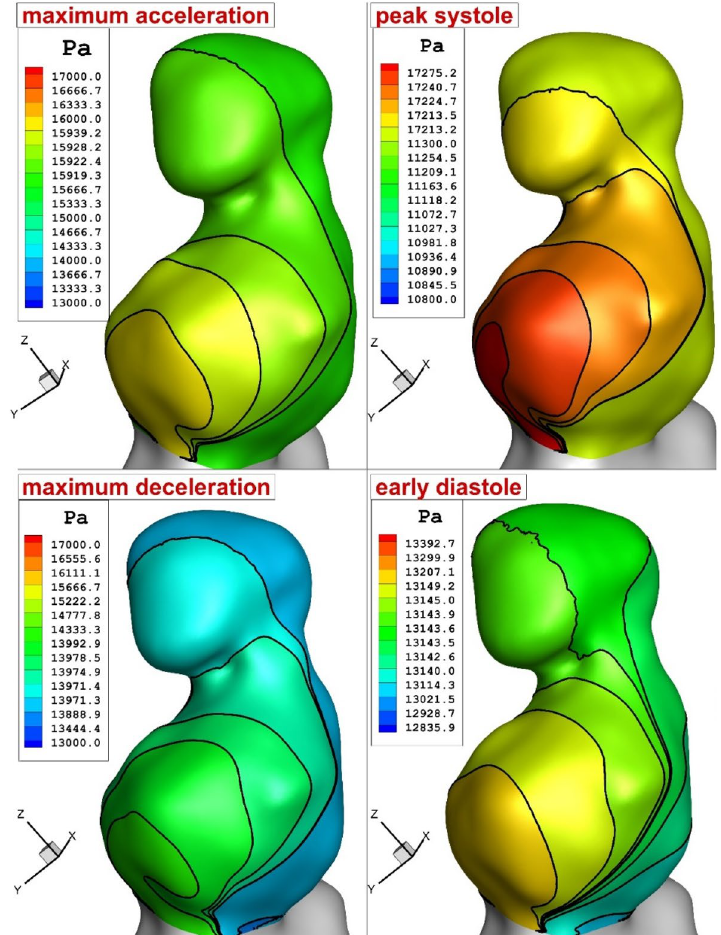
Figure 5. Wall pressure distribution in different time instants.